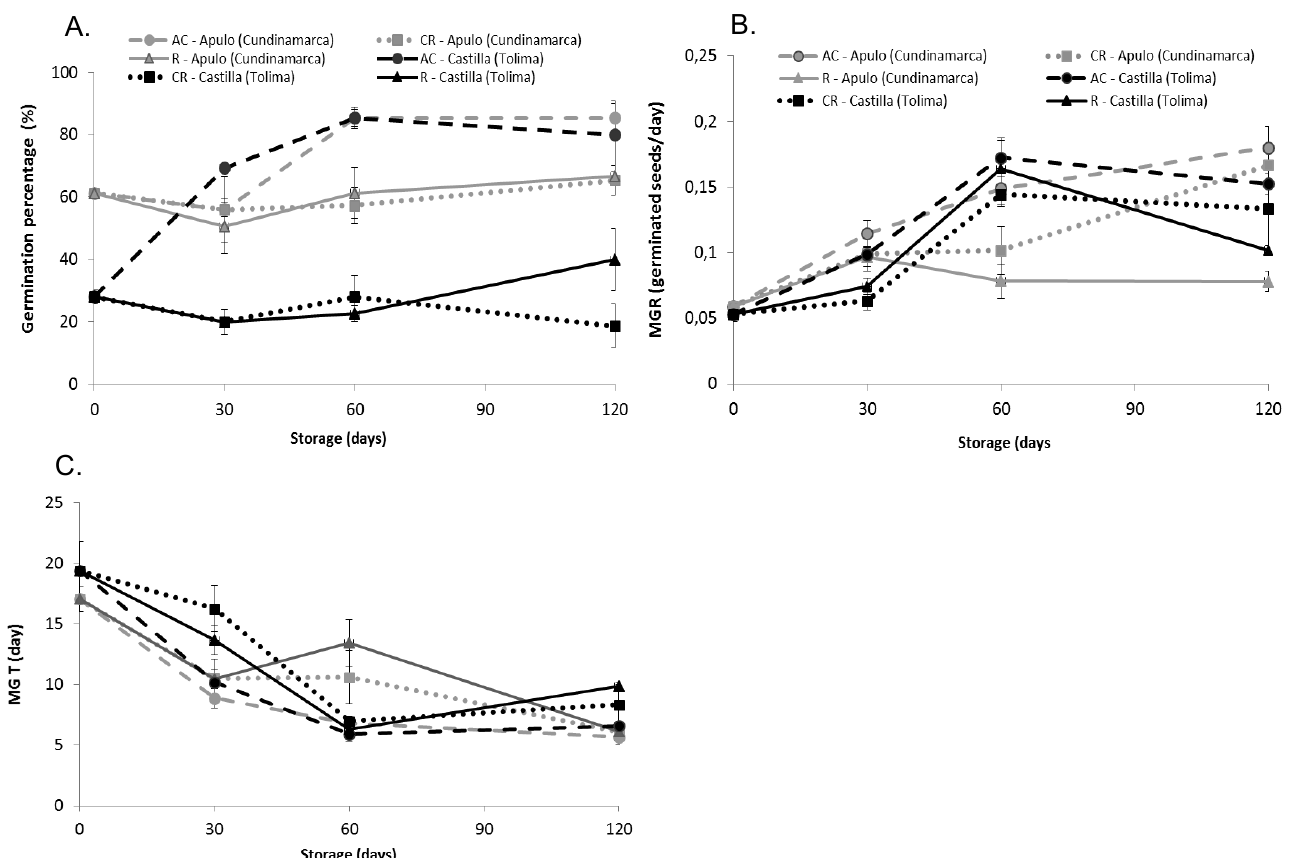
Fig. 1: Germination percentage GP (A), mean germination rate MGR (B), and mean germination time MGT (C) of A. squamosa L. seeds from Castilla-Tolima (black lines) and Apulo-Cundinamarca (gray lines) under ambient conditions AC (dashed lines), cool room CR (continuous points) and refrigeration R (solid lines). Germination incubation was at 35 °C and 60% RH in wet peat. Vertical bars indicate standard error (±), n = 4.